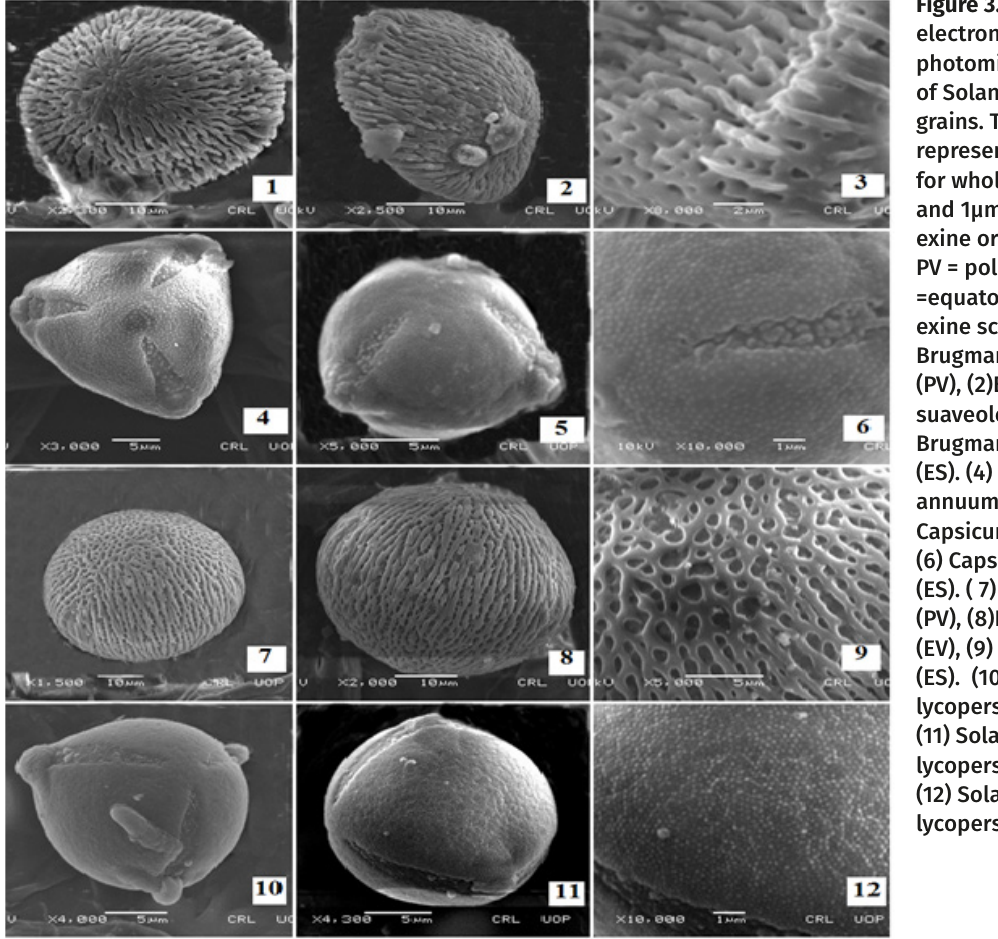
Figure 3. S Scanning electron microscope photomicrographs (SEM) of Solanaceous